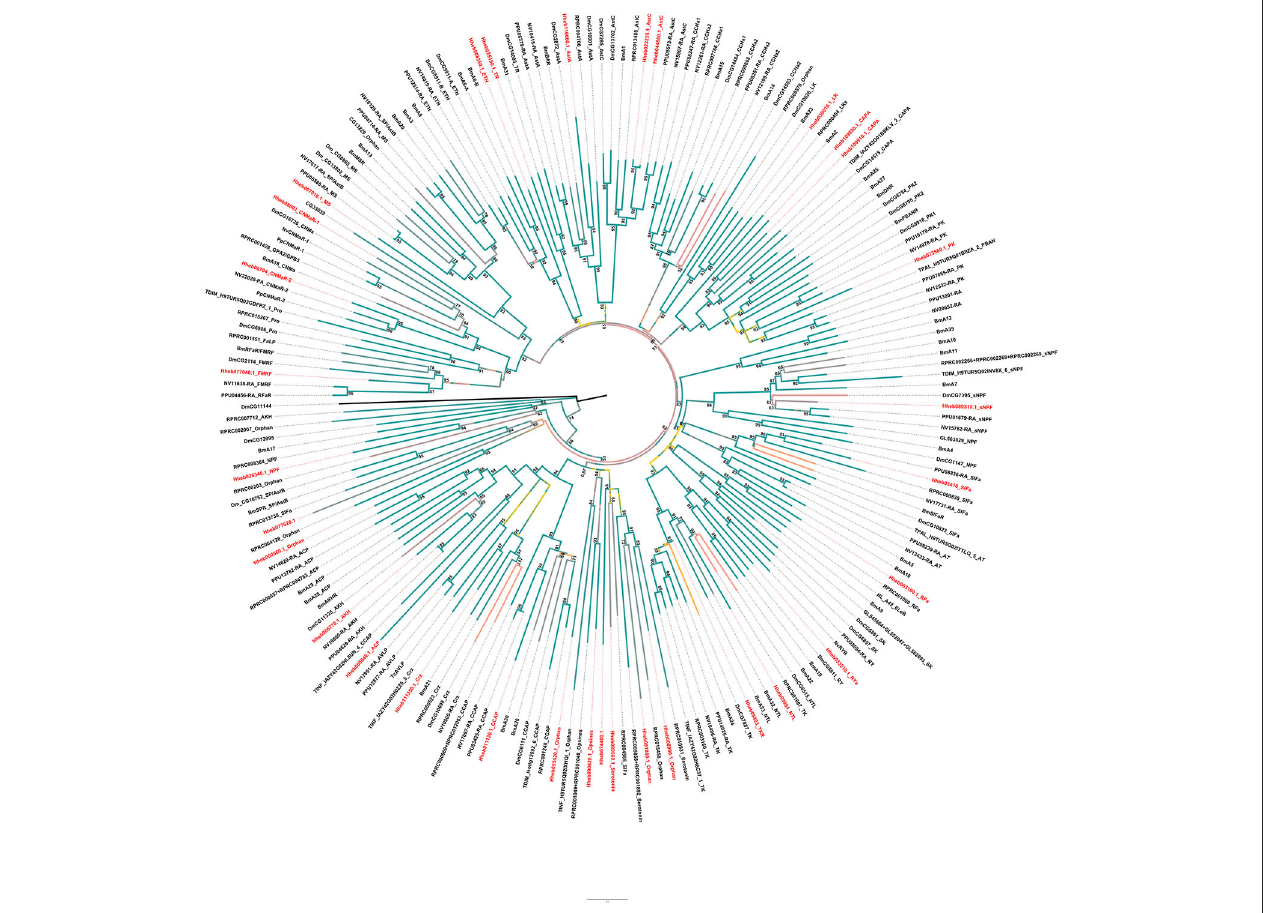
FIGURE 4 | Phylogenetic tree analysis of the family-A neuropeptide GPCRs in the Cluster from H. hebetor (Hh), B. mori (Bm), D. melanogaster (Dm), P. puparum (Pp), N. vitripennis (Nv), Rhodnius prolixus (RPR), Triatoma dimidiate (TDIM), Triatoma infestans (TINF), Triatoma pallidipennis (TPAL), and T. castaneum (Tc). The numbers at the nodes of branches indicate the posterior probability for each branch. The GPCRs from H. hebetor are highlighted in red. The amino acid sequences used are listed in the Supplementary Material File 3